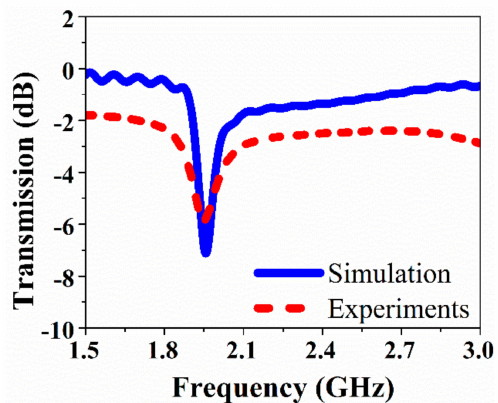
Figure 4. Simulated and measured results of the transmission coe ffi cient when air is present in the sensor